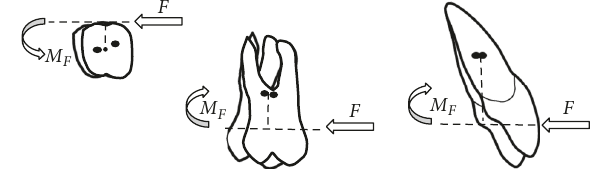
Figure 3: Moment ( M ) produced by a force not acting through 𝐶 res